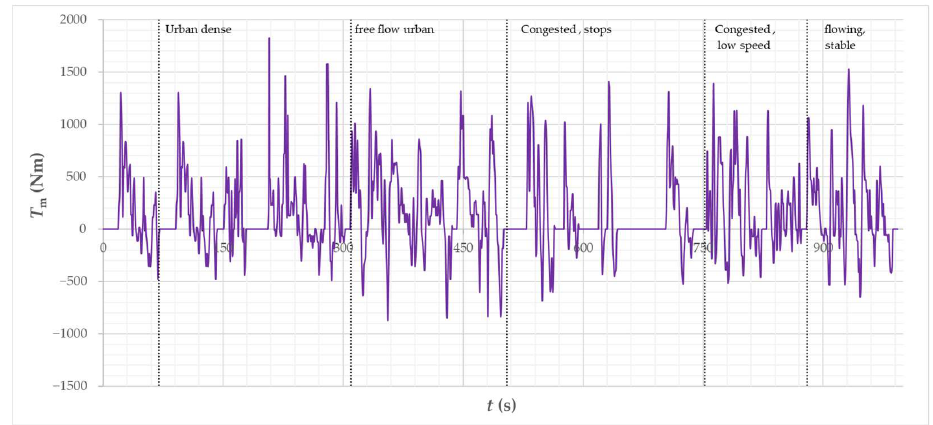
Figure 16. Vehicle torque waveform of the Artemis Urban cycle .